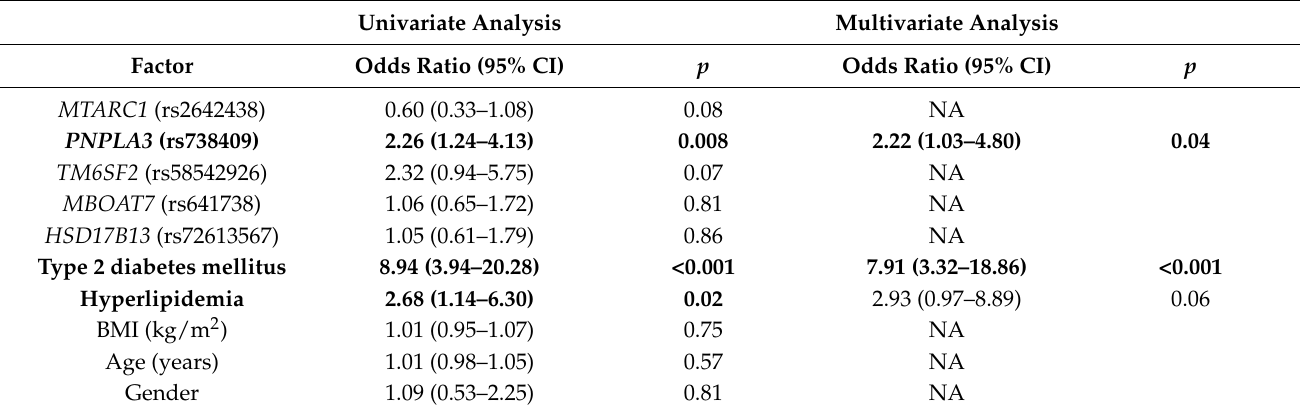
Table 6. Risk and protective factors for